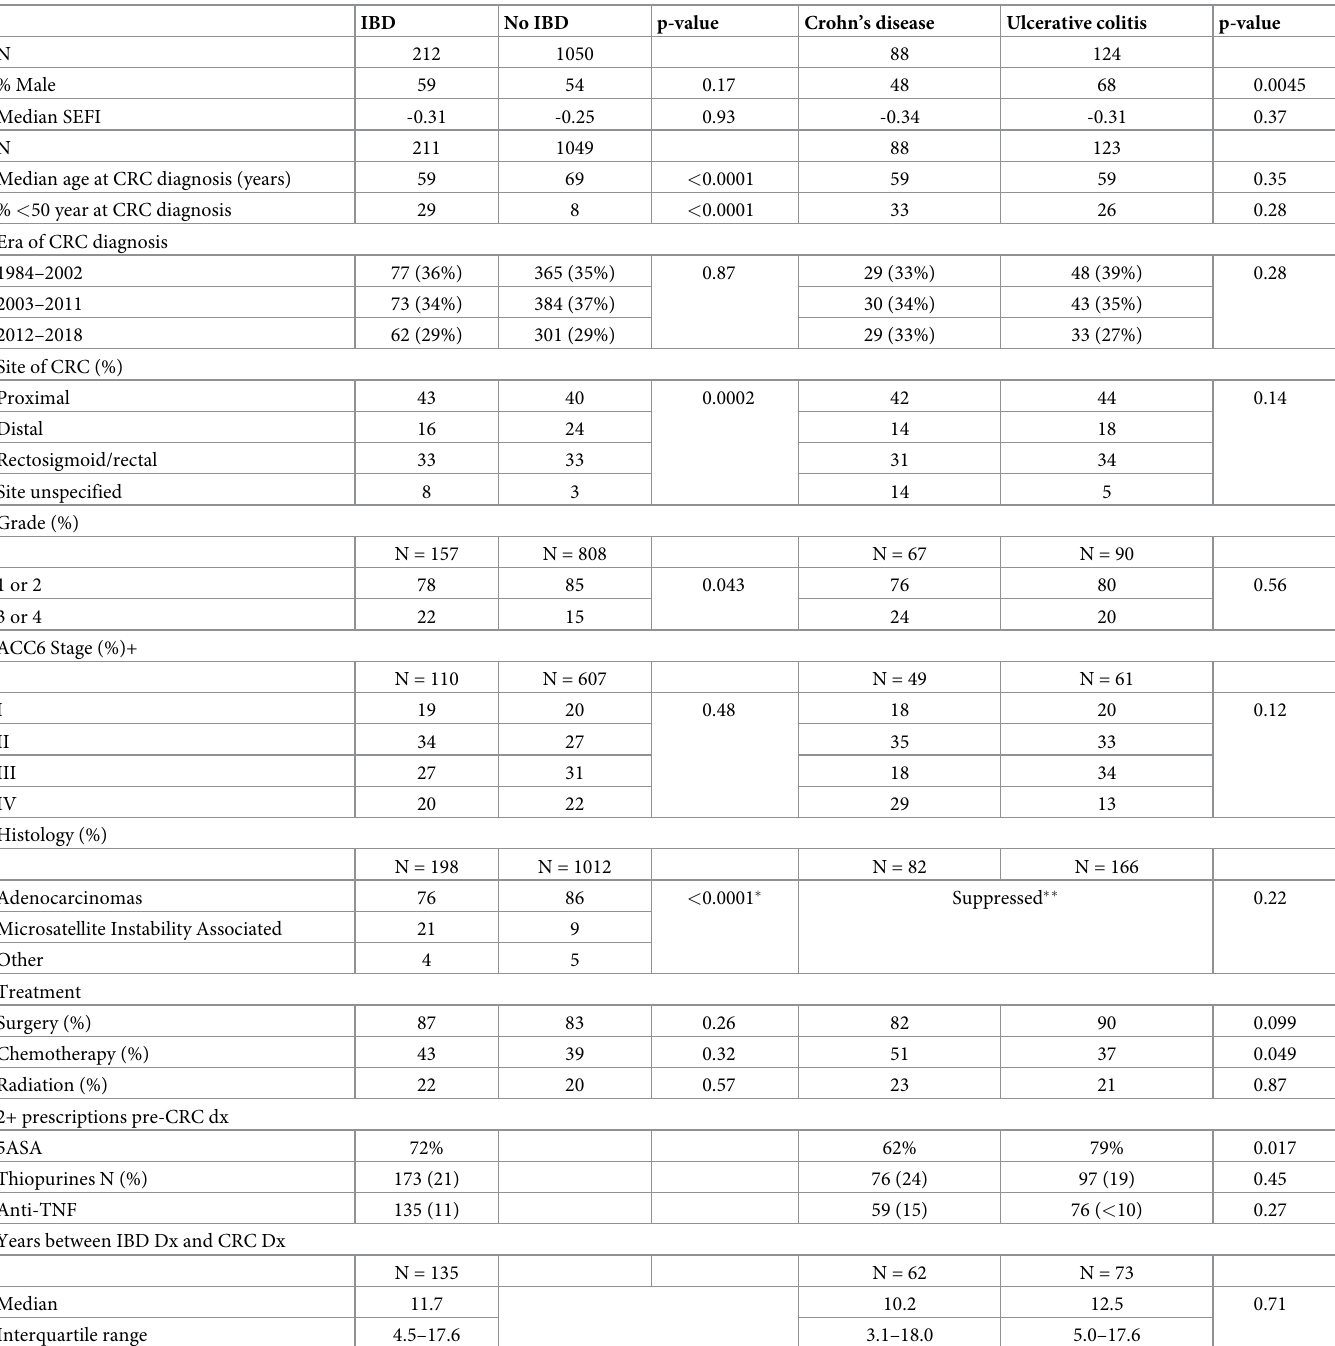
Table 1. Demographics of the study population with colorectal cancer stratified by inflammatory bowel disease